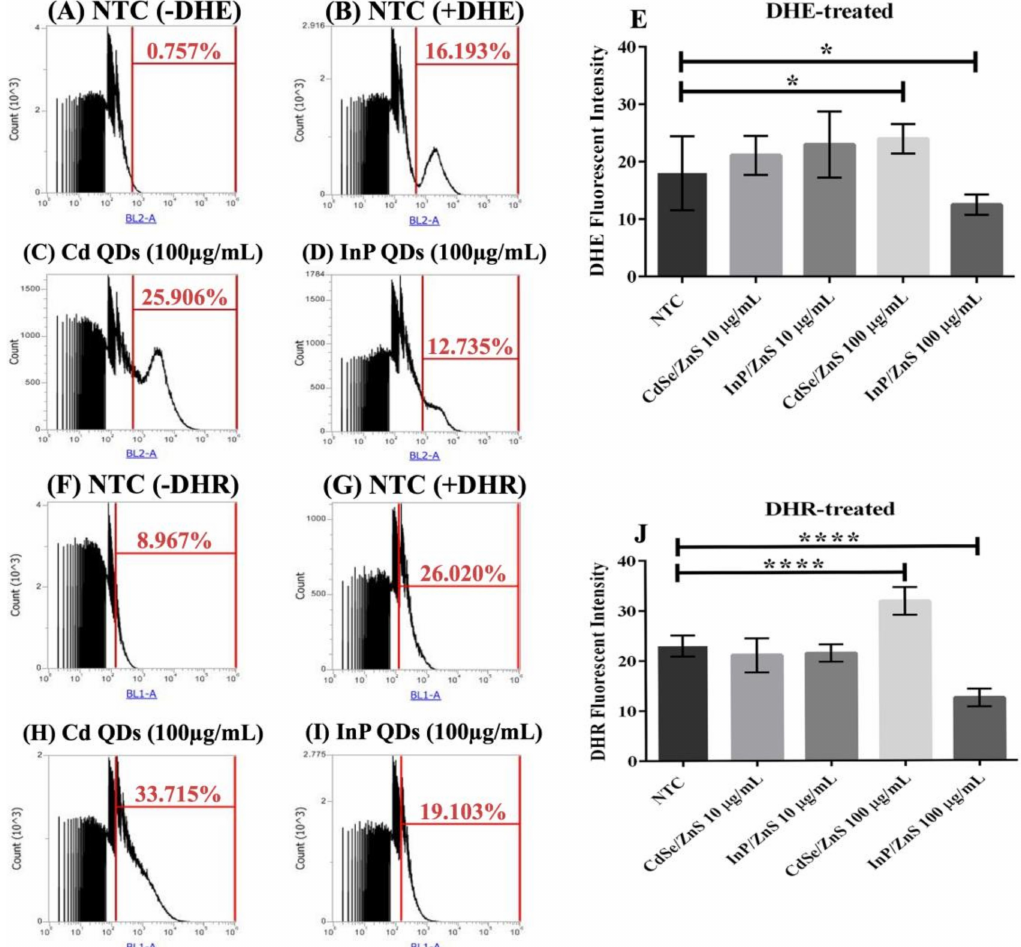
Figure 4. Quantification of reactive oxygen species (ROS) levels including superoxide and peroxynitrite generated by cells treated with CdSe/ZnS and InP/ZnS QDs at 10 and 100 µ g/mL, respectively. Samples were treated with and incubated with dihydroethidium (DHE) or dihydrorhodamine (DHR) 2 h prior to measuring the oxidized DHE and DHR fluorescent byproducts, which we measured with flow cytometry, that allow us to observe changes in superoxide and peroxynitrite levels generated in each QD-treatment, respectively. ( A ) Non-treated sample without DHE. ( B ) Non-treated sample dyed with DHE. ( C ) DHE dyed sample treated with 100 µ g/mL CdSe/ZnS. ( D ) DHE dyed sample treated with 100 µ g/mL InP/ZnS. ( E ) Bar graph comparing % changes in superoxide levels. ( F ) Non-treated sample without DHR. ( G ) Non-treated sample dyed with DHR. ( H ) DHR dyed sample treated with 100 µ g/mL CdSe/ZnS. ( I ) DHR dyed sample treated with 100 µ g/mL InP/ZnS. ( J ) Bar graphs comparing % changes in peroxynitrite levels. One asterisk represent p < 0.05 and four asterisk represent p <